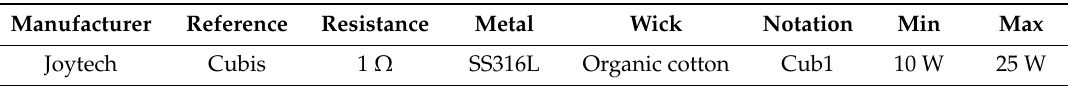
Table 3. Manufacturer’s general information about the reference clearomiser in this study (Cubis clearomiser with a 1 Ω Table 3. Manufacturer ’s general information about the reference clearomiser in this study (Cubis clearomiser with a 1 Ω coil).